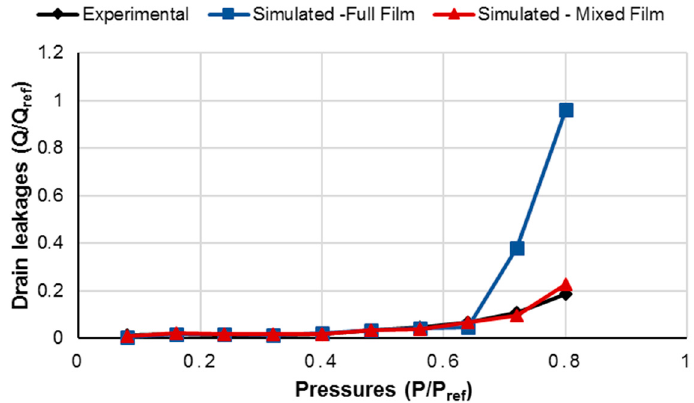
Figure 13. Comparison of measured drain leakages with the simulated ones from the full and mixed film models at an operating speed of 500 rpm.